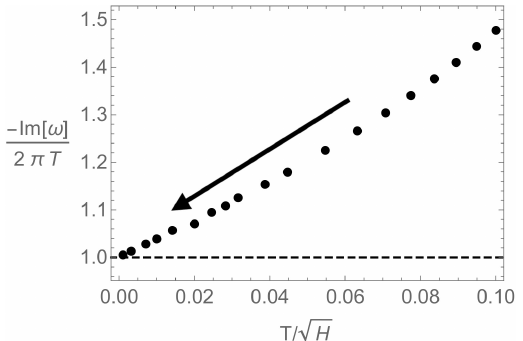
Figure 1 . The first non-hydrodynamic mode at k/T = 1 / 10 . Black dots are quasi-normal modes and the dashed line is ω (3.14). 0